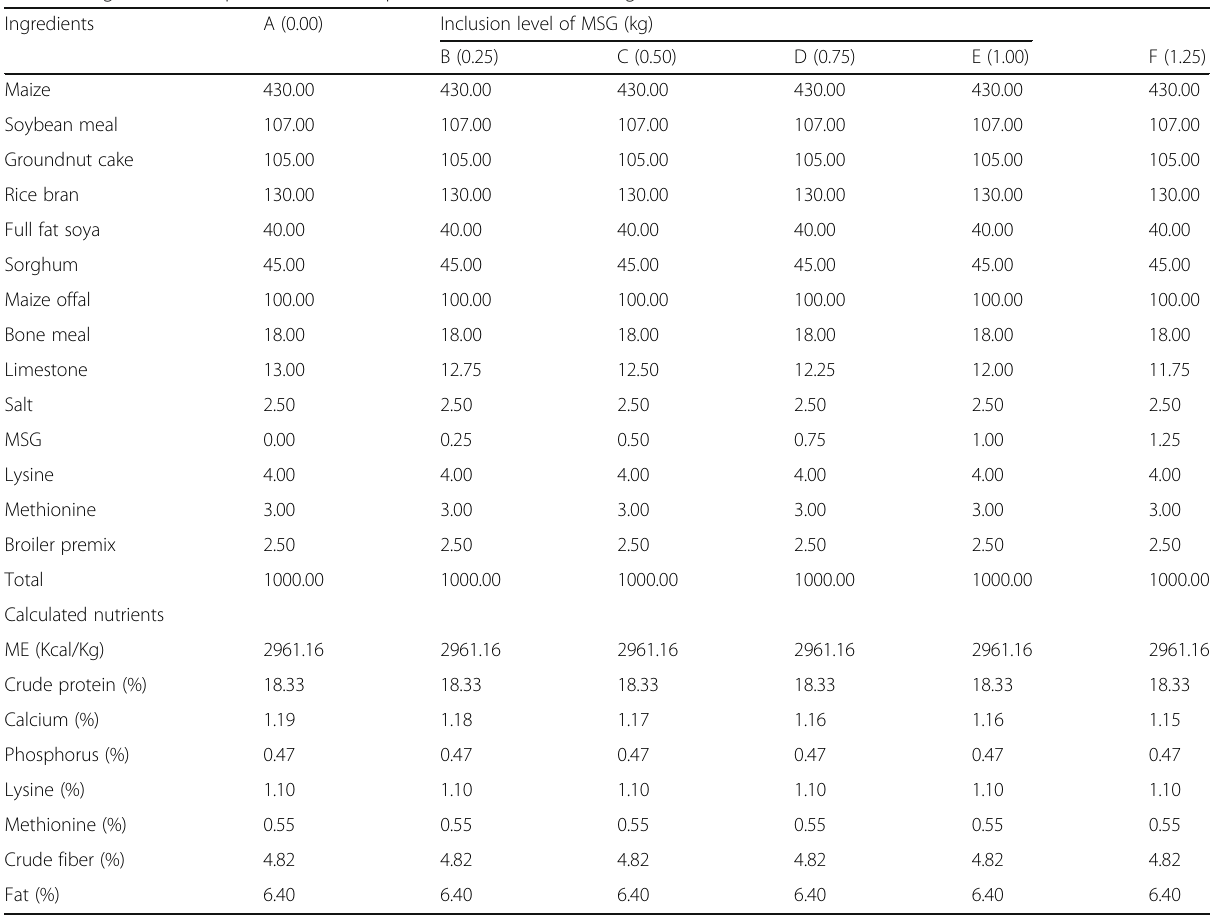
Table 2 Ingredient composition of the experimental finisher diets (kg)